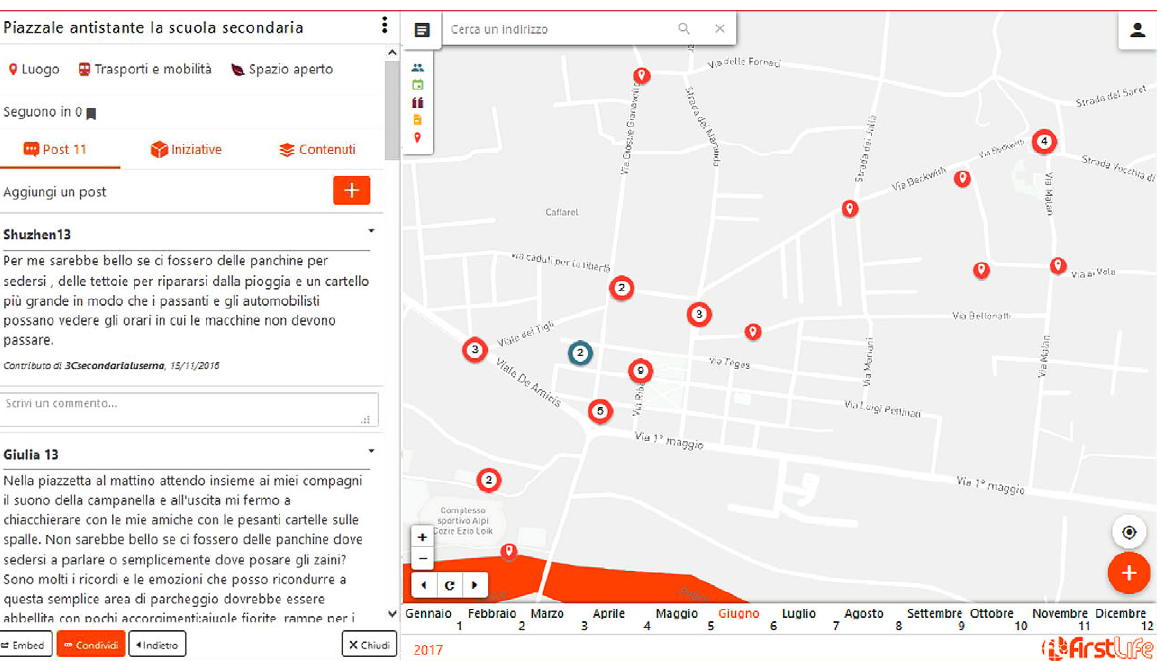
Fig. 11. Screenshot of Web-based application FirstLife